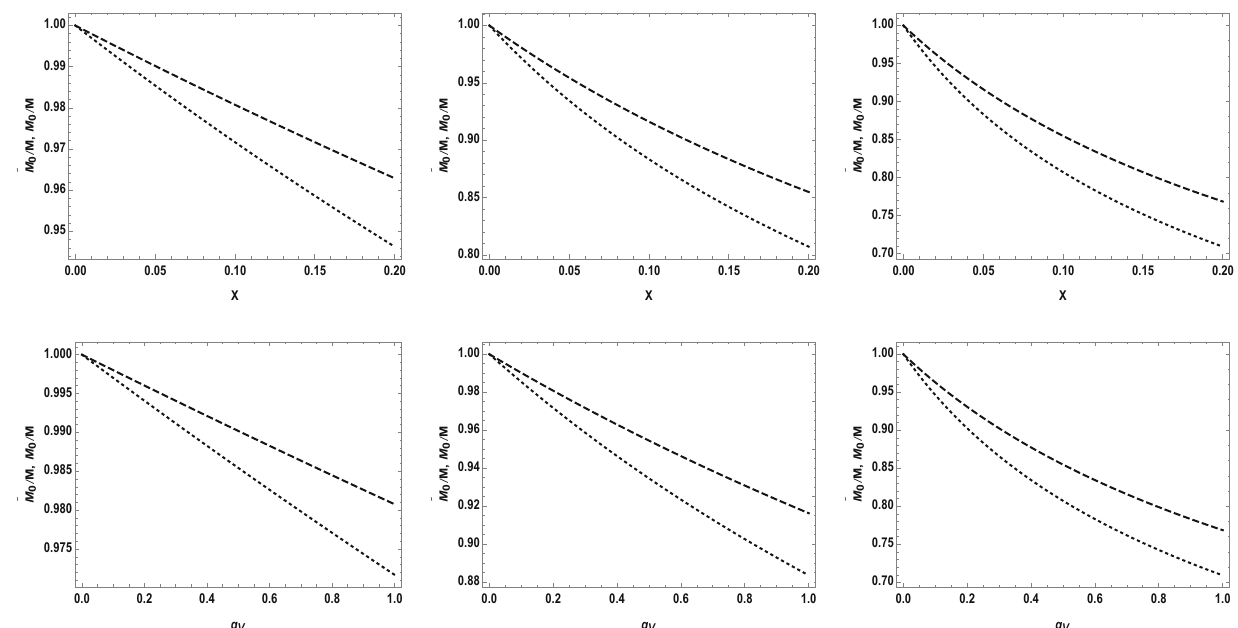
line) and M 0 / M (dashed line) as functions of q V for X = 1 / 100 (left panel), X = 1 / 20 (center panel) and X = 1 / 5 (right panel)